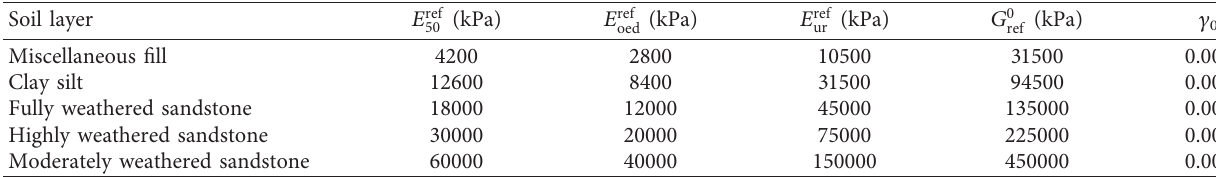
Table 2: Soil parameters in the numerical analysis.